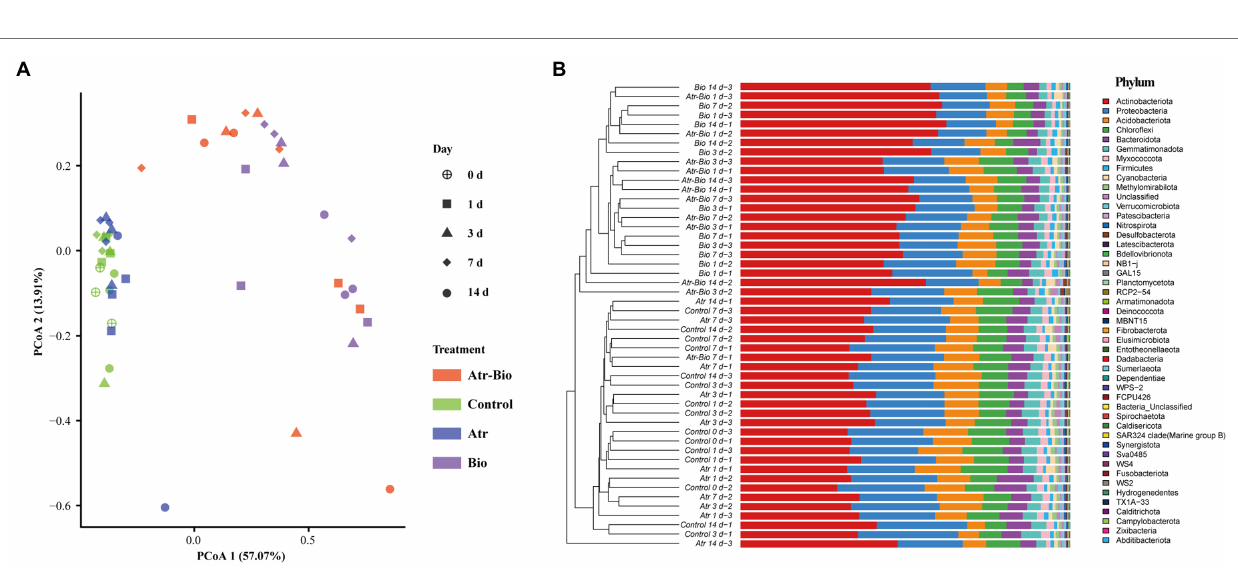
FIGURE 4 | Effects of the different treatments on the bacterial community structure. (A) principal coordinates analysis (PCoA) with Bray–Curtis distances of bacterial communities; (B) Hierarchical clustering based on relative abundances of bacterial phylum in the soil samples. Control: equivalent amount of methanol and ddH 2 O were added into native soil; Atr: native soil spiked with atrazine; Atr-Bio: atrazine-spiked soil with inoculation of strain AT-5; Bio: native soil with inoculation of strain